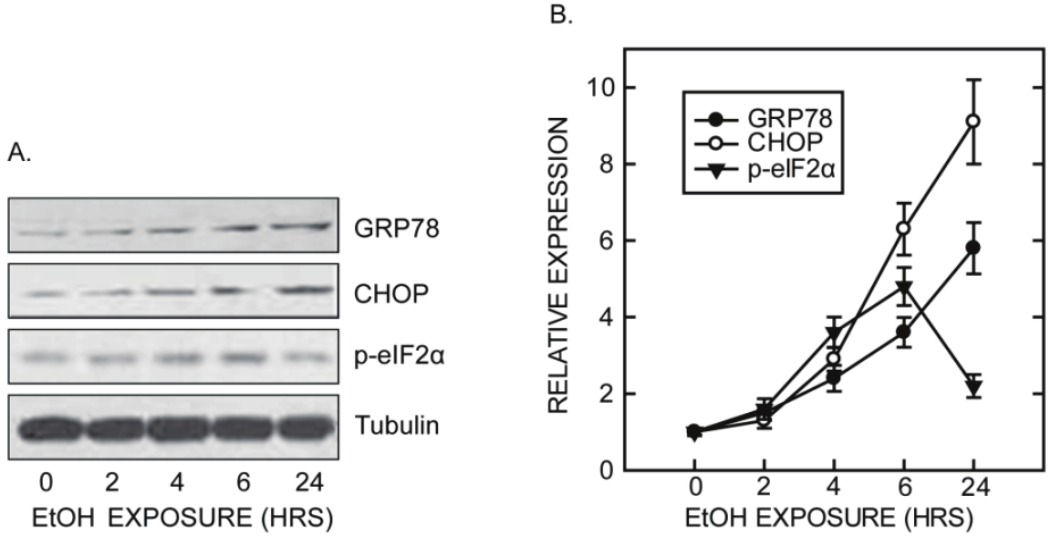
Figure 2. Time course of ethanol-induced ER stress in the developing brain adapted from data published by Ke, Z. et al. [5]. ( A ) Mice PD7 were subcutaneously injected with ethanol or saline as described in Figure 1. At 2, 4, 6, and 24 h after ethanol injection, animals were sacrificed and protein from the cerebral cortex was extracted. The expression of GRP78, CHOP, p-eIF2(cid:2), and tubulin was analyzed with immunoblotting; ( B ) the protein expression was quantified by densitometry, normalized to the level of actin and presented as mean ± SEM